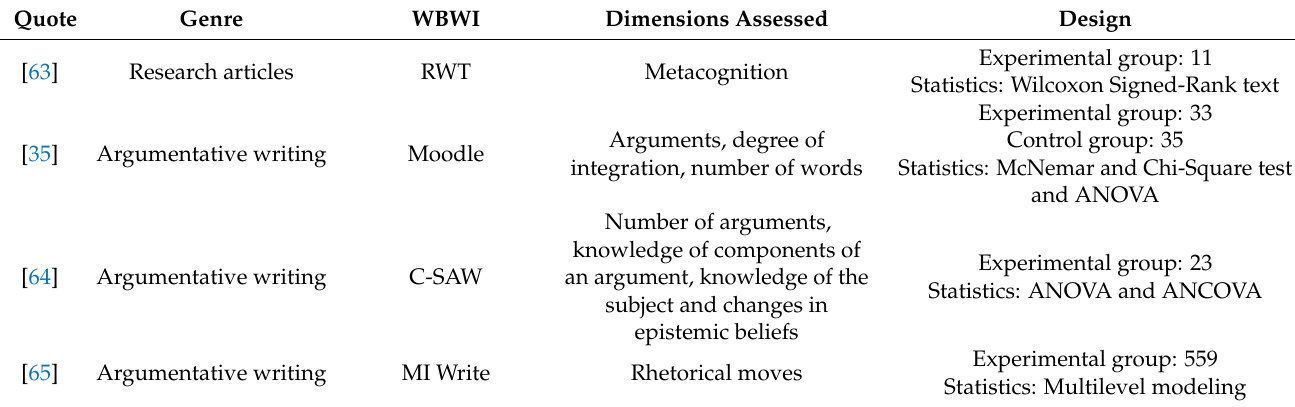
Table 1. Current studies illustrating how WBWI can be implemented at the university level.